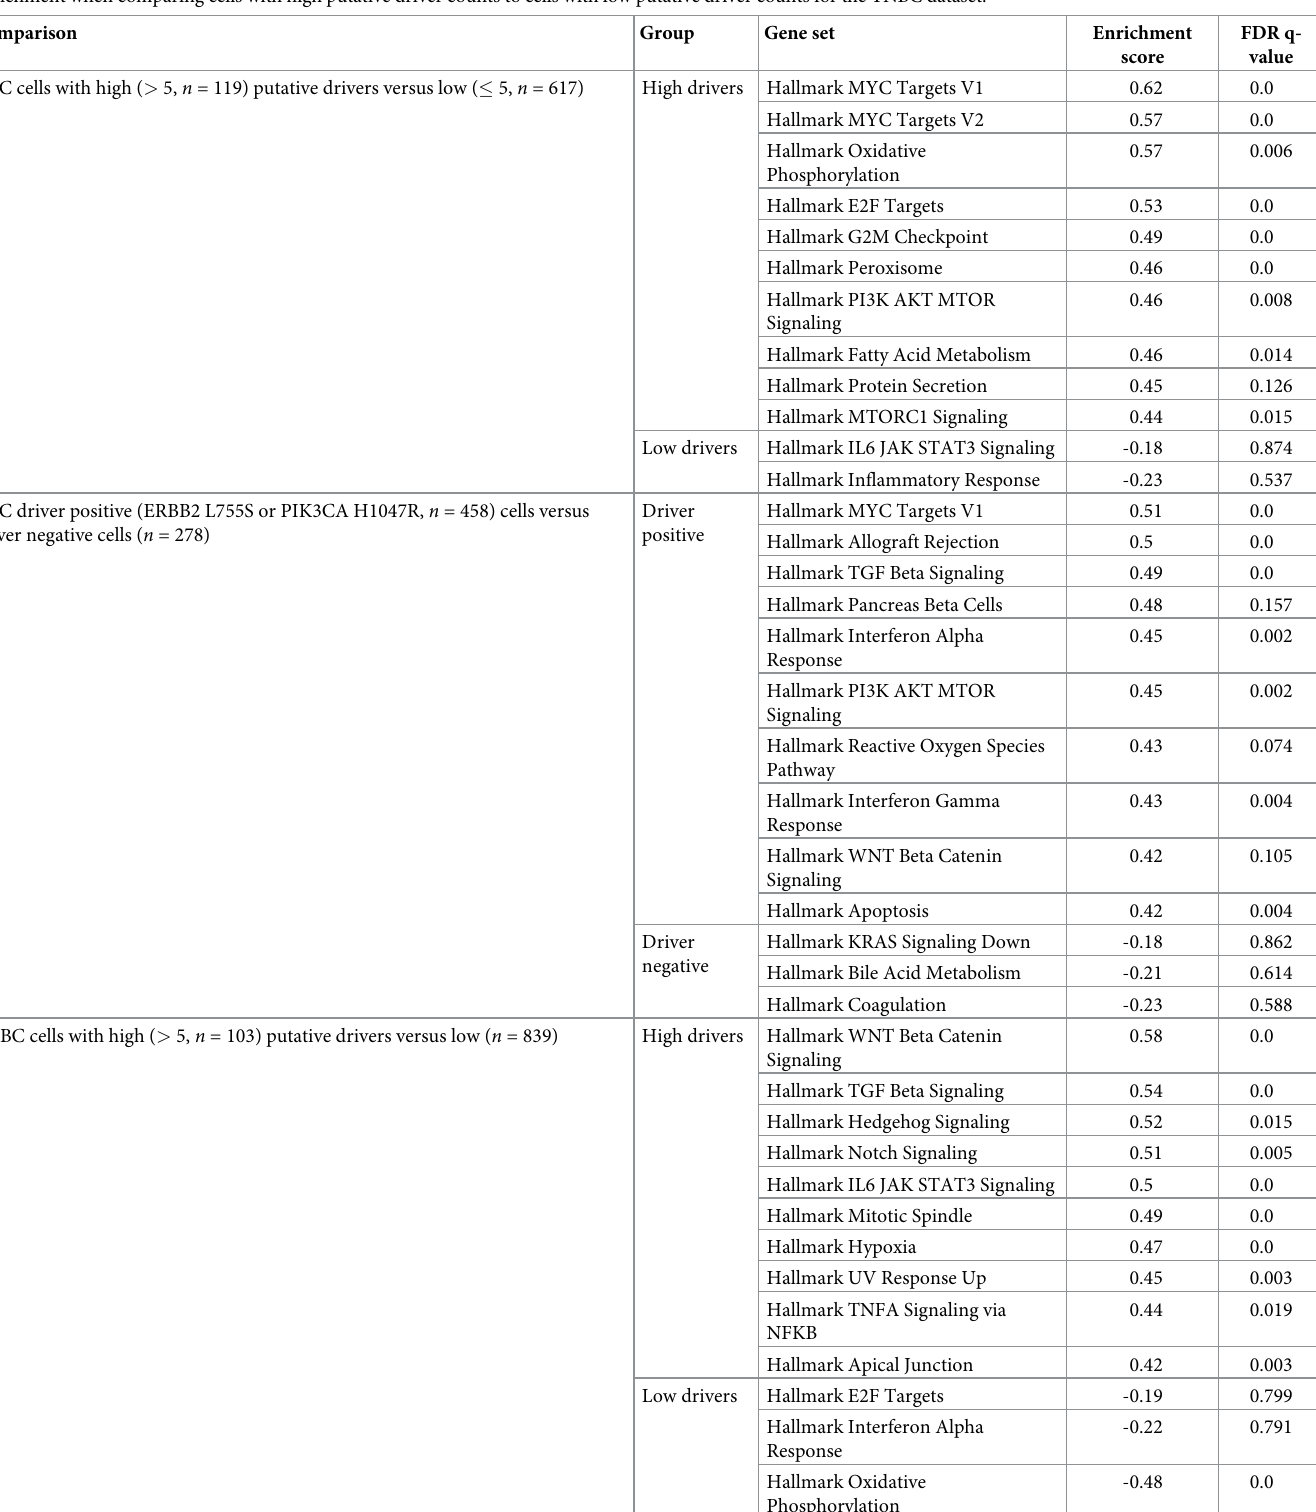
Table 2. Gene set enrichment analysis results showing top 10 enriched cancer hallmark gene sets by enrichment score for groups of driver enriched cells versus all others. Top section shows enrichment when comparing cells with high putative driver counts to cells with low putative driver counts for the CRC dataset. Middle section shows enrichment when comparing ERBB2+/PIK3CA+ cells to cells lacking the characteristic ERBB2 or PIK3CA mutations for the CRC dataset. Bottom section shows enrichment when comparing cells with high putative driver counts to cells with low putative driver counts for the TNBC dataset. Comparison